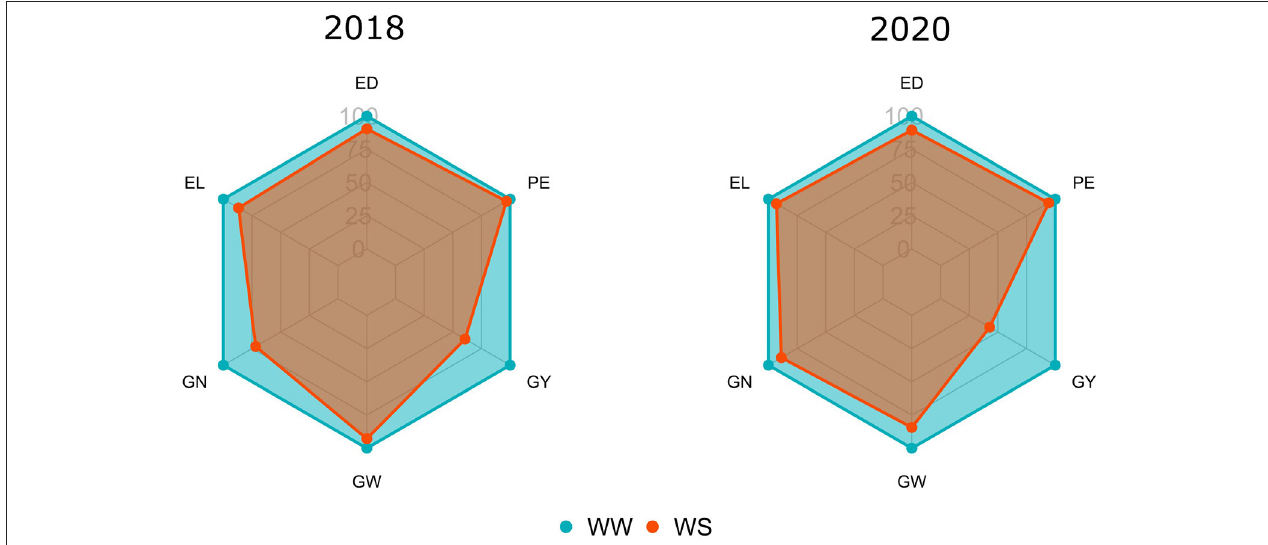
FIGURE 1 | Relative percentages of the means evaluated under water stress (WS) in relation to the well-watered (WW) condition for agronomic traits [GY, grain yield; PE, popping expansion; GN, grain number per row (unit); EL, ear length; ED, ear diameter; GW, 100-grain weight] evaluated in popcorn genotypes during